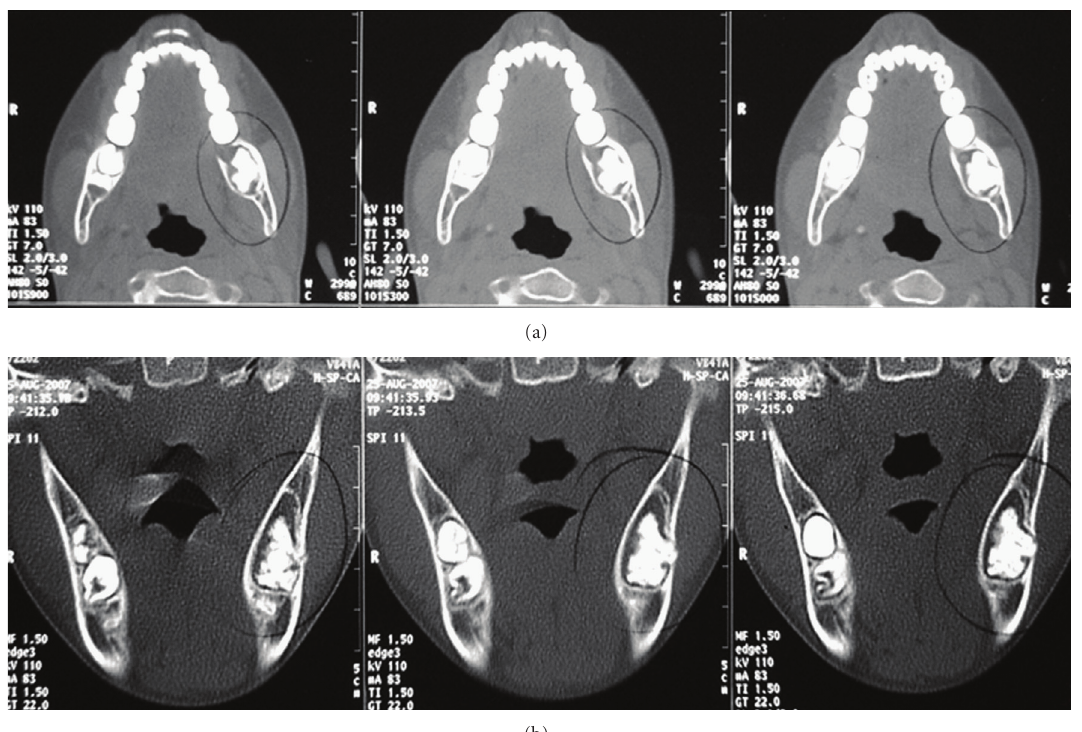
Figure 2: Helical computed tomography images showing an expansile, well-circumscribed lesion containing a calcified mass compatible with odontogenic tissue ((a) axial cuts; (b) coronal